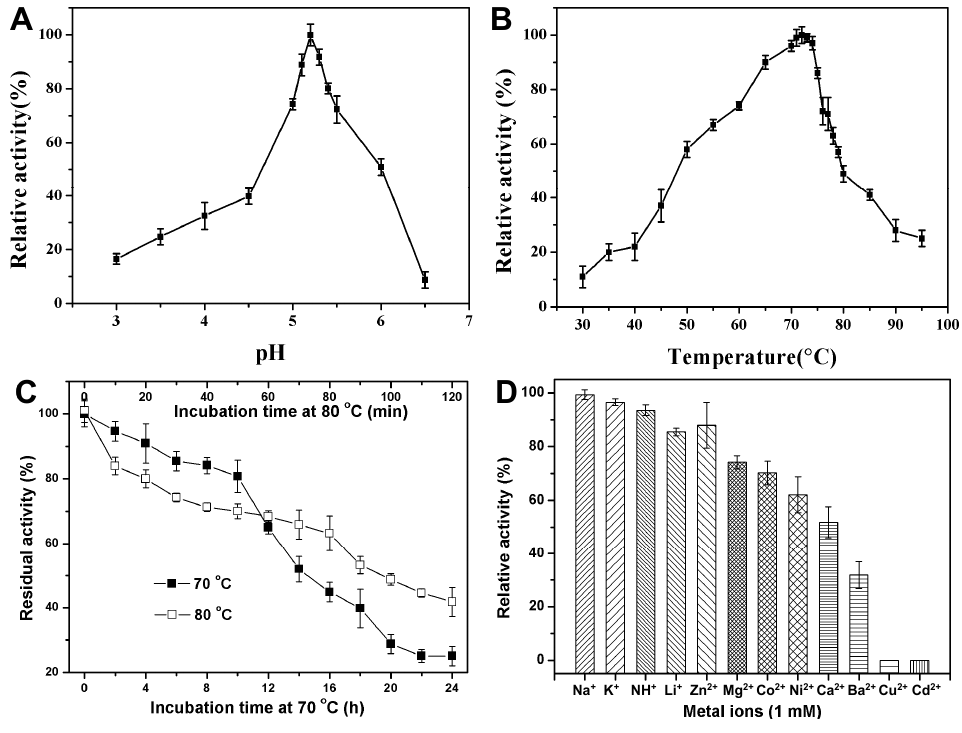
Figure 4. Mean (SD) of various properties of CbPelA. ( A ) Effect of pH; ( B ) Effect of temperature; ( C ) Thermo-stability; ( D ) Effect of metal ions. Mean (SD) was calculated from three independent